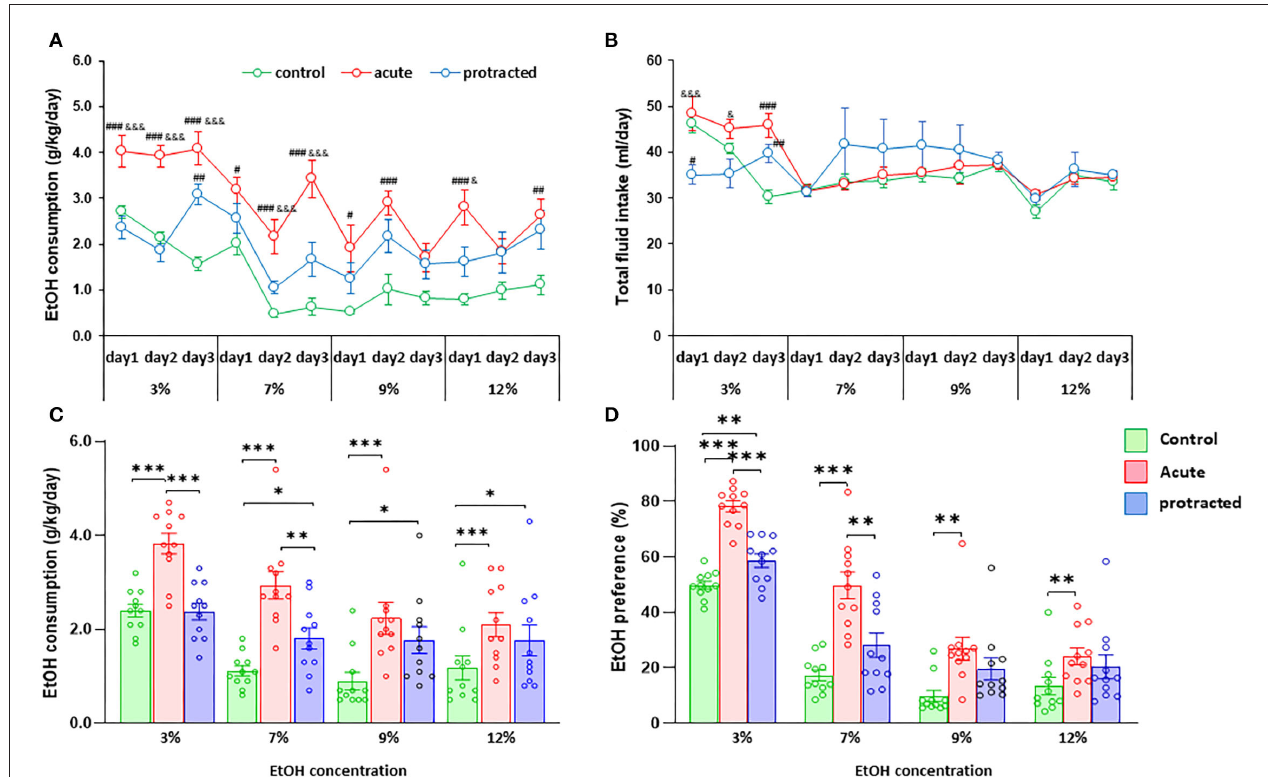
FIGURE 3 | Protracted and acute prenatal stress-induced excessive ethanol intake in young adult male offspring at age of PND70. Ethanol (EtOH) drinking behavior was measured using two-bottle free-choice test. In (A,C) , a daily and means of 3-day ethanol consumption at given concentrations with corresponding control groups shows that male rats born from dams subjected to either protracted or acute stress developed significantly high ethanol consumption and preference (D) characterized by excessive ethanol intake (g/kg/day) to all four concentrations of ethanol provided and less water intake. * p < 0.05, ** p < 0.01, *** p < 0.001: Protracted, Acute vs. Control; # p < 0.05, ## p < 0.01, ### p < 0.001: Protracted, Acute vs. Control; & p < 0.05, && p < 0.01, &&& p < 0.001: Acute vs. Protracted. (B) Shows total fluid intake in three groups. 2-way repeated ANOVA, n = 11 for each group. Values are the mean ± SEM. Individual value is shown with circle dot on bar